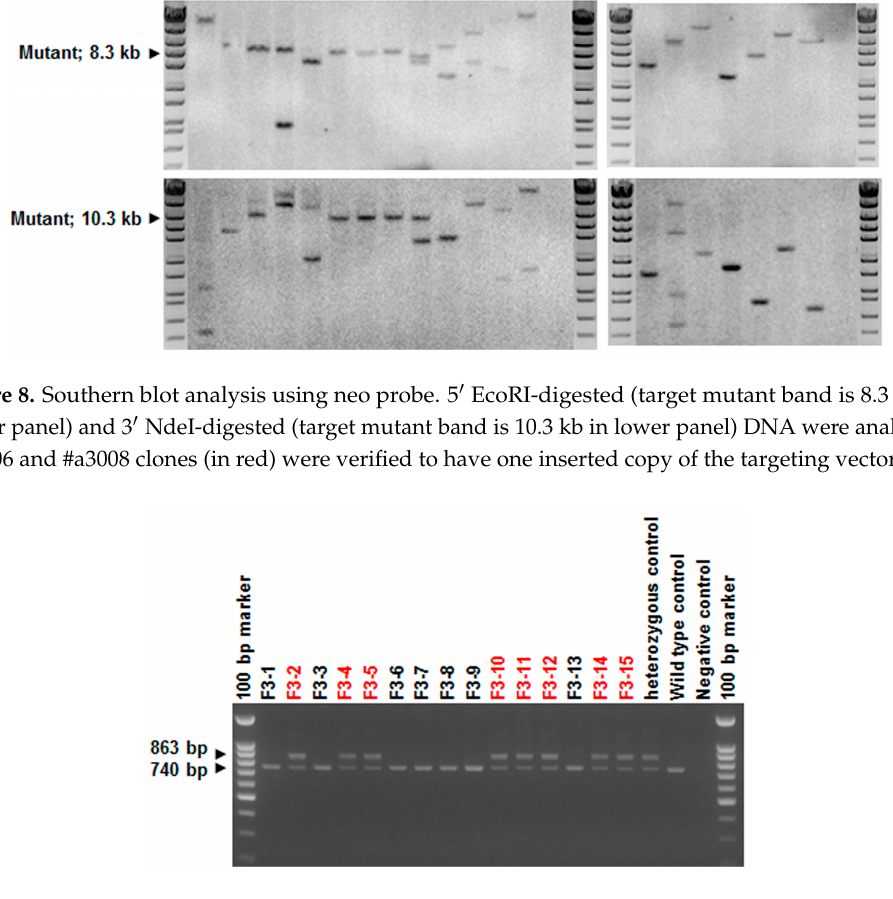
Figure 9. Agarose-gel electrophoresis of PCR products amplified to detect first loxP using the primer set F23005 and R23744. Analyzed DNAs (F3-1–F3-15) were from F3 mice with heterozygous Agtrap floxed allele from which the PGK-Neo cassette was removed. The red-labeled sample were positive for loxP site amplification.